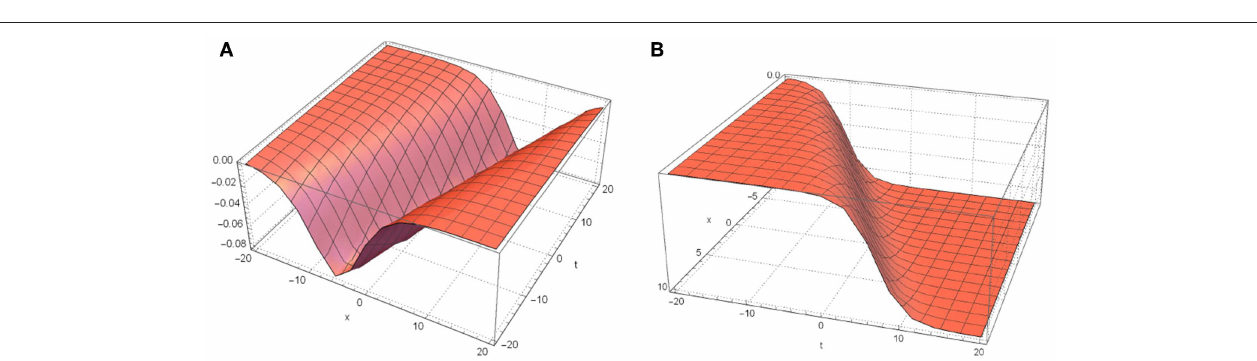
1.2, k 3 2, k 4 2. (A) u 1 ( x , t ). (B) u 2 ( x , t ). = = = −